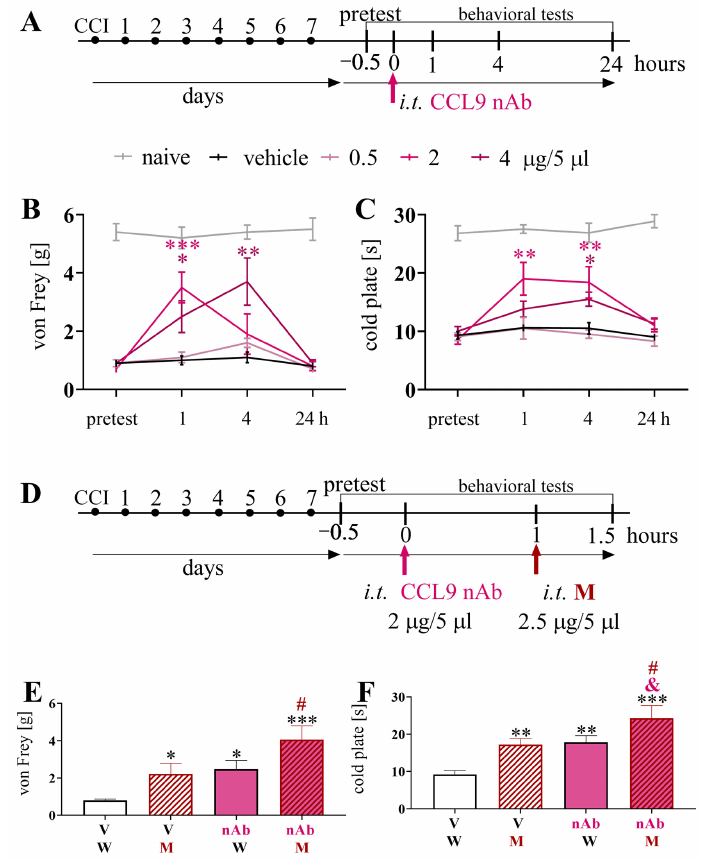
Figure 4. The effects of CCL9 neutralizing antibody administered intrathecally (i.t.) according to timeline ( A ), at doses of 0.5, 2, and 4 µ g/5 µ L on mechanical ( B ) and thermal ( C ) hypersensitivity, and the influence of a CCL9 neutralizing antibody at a dose of 2 µ g/5 µ L plus morphine 2.5 µ g/5 µ L on mechanical ( E ) and thermal ( F ) hypersensitivity, administered according to timeline ( D ), 7 days CCI in mice. The data are presented as the mean ± SEM (naive n = 5; CCI n = 5–8). The results were evaluated using one-way ANOVA followed by Bonferroni’s post hoc test for comparisons of selected pairs. * p < 0.05, ** p < 0.01, and *** p < 0.001 indicate significant differences vs. V-treated group at each of the investigated time points: 1, 4, and 24 h for ( B,C ) graphs; * p < 0.05, ** p < 0.01, and *** p < 0.001 indicate significant differences vs. V + W-treated group for ( E,F ) graphs; # p < 0.05 indicates significant differences between the V + M- and nAb + M-treated groups for ( E , F ) graphs; and & p < 0.05 indicates significant differences between the nAb + W- and nAb + M-treated groups. Abbreviations: V: vehicle (PBS); W: vehicle ( aqua pro injectione ); nAb: neutralizing antibody;